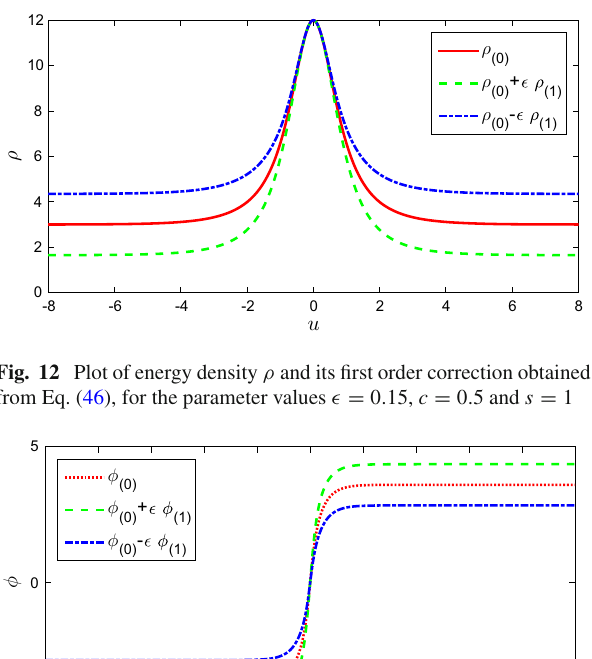
Fig. 11 Plot of the scale factor and its first order correction, obtained from Eq. (46), for the values (cid:9) = 0.15, c = 0.5 and s = 1